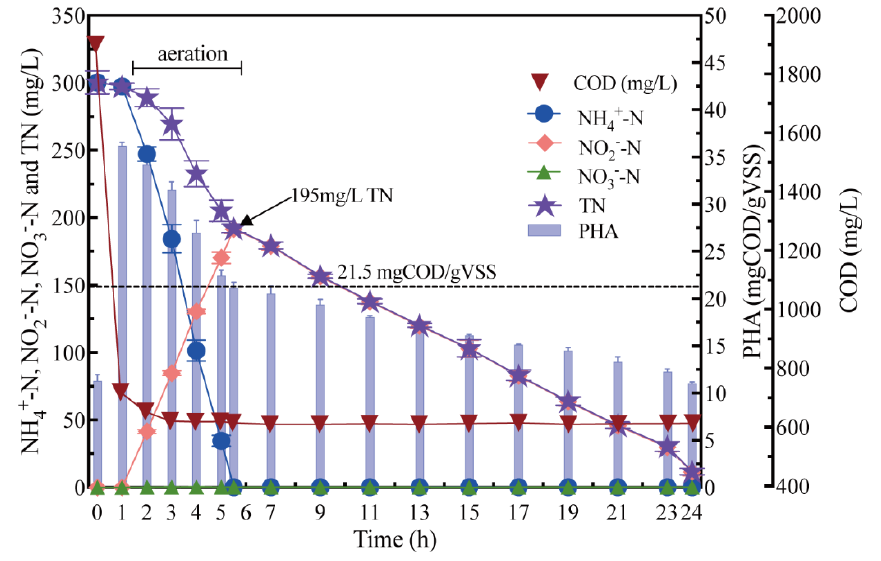
Figure 6. The variation of indices over typical cycles of stability period of SBR.